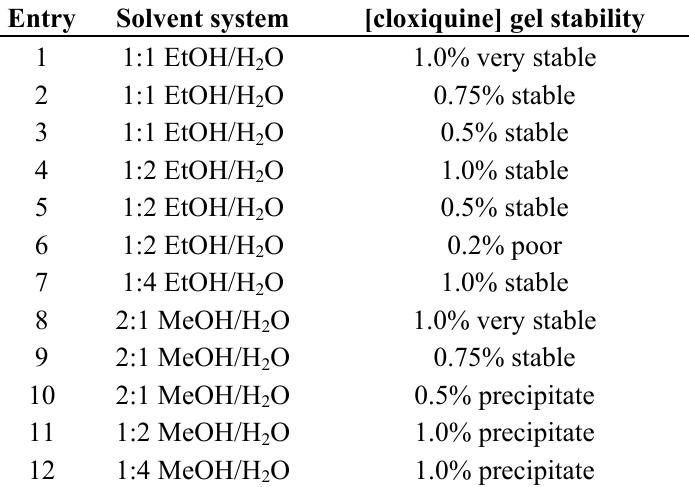
Table 1. Gelation data of 5-chloro-8-hydroxyquinoline